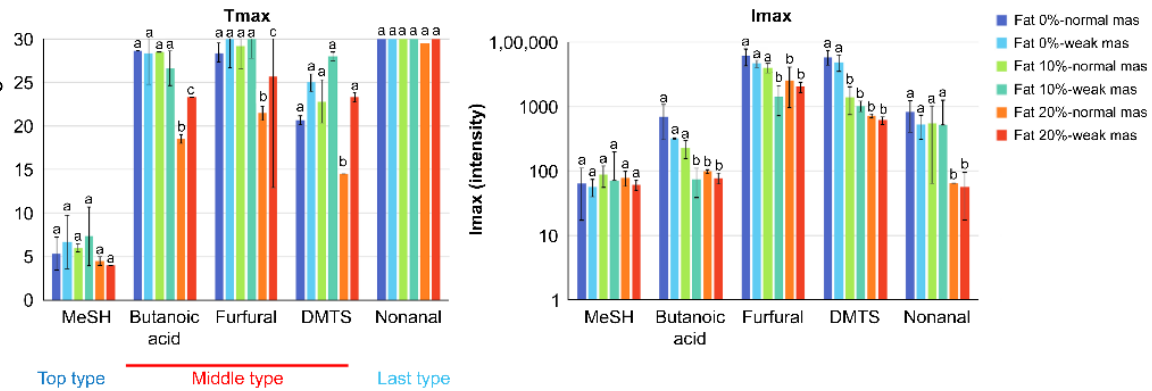
Figure 1. Changes in the release of aroma compounds caused by differences in the mastication (mas) strengths (normal and weak) and in the amounts of fat (Tmax and Imax). Statistical analyses were performed independently for each aroma compound. Different letters on top of bars mean significant differences ( α < 0.05).